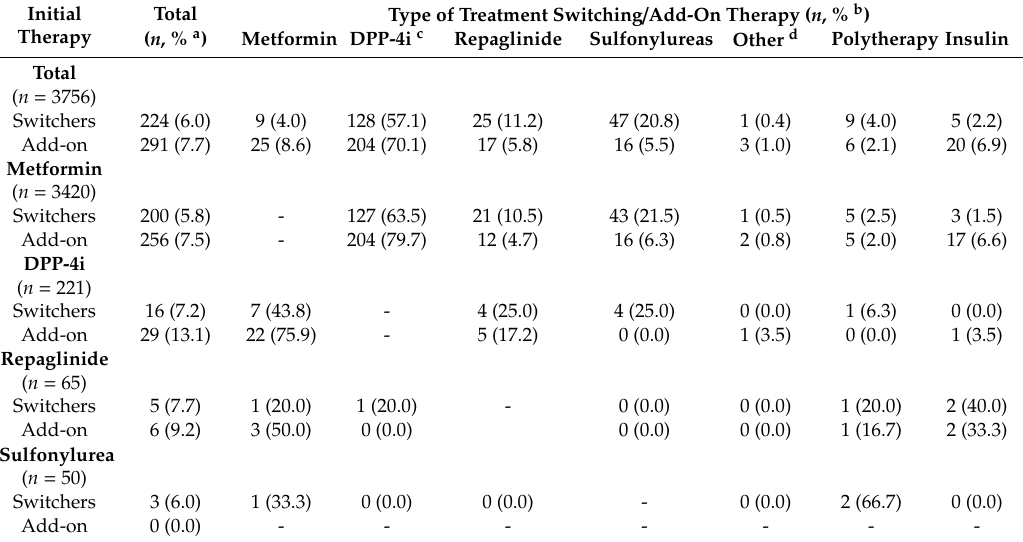
Table 2. Treatment switching and add-on therapy patterns among new users of antidiabetic drugs initiated on monotherapy (objective